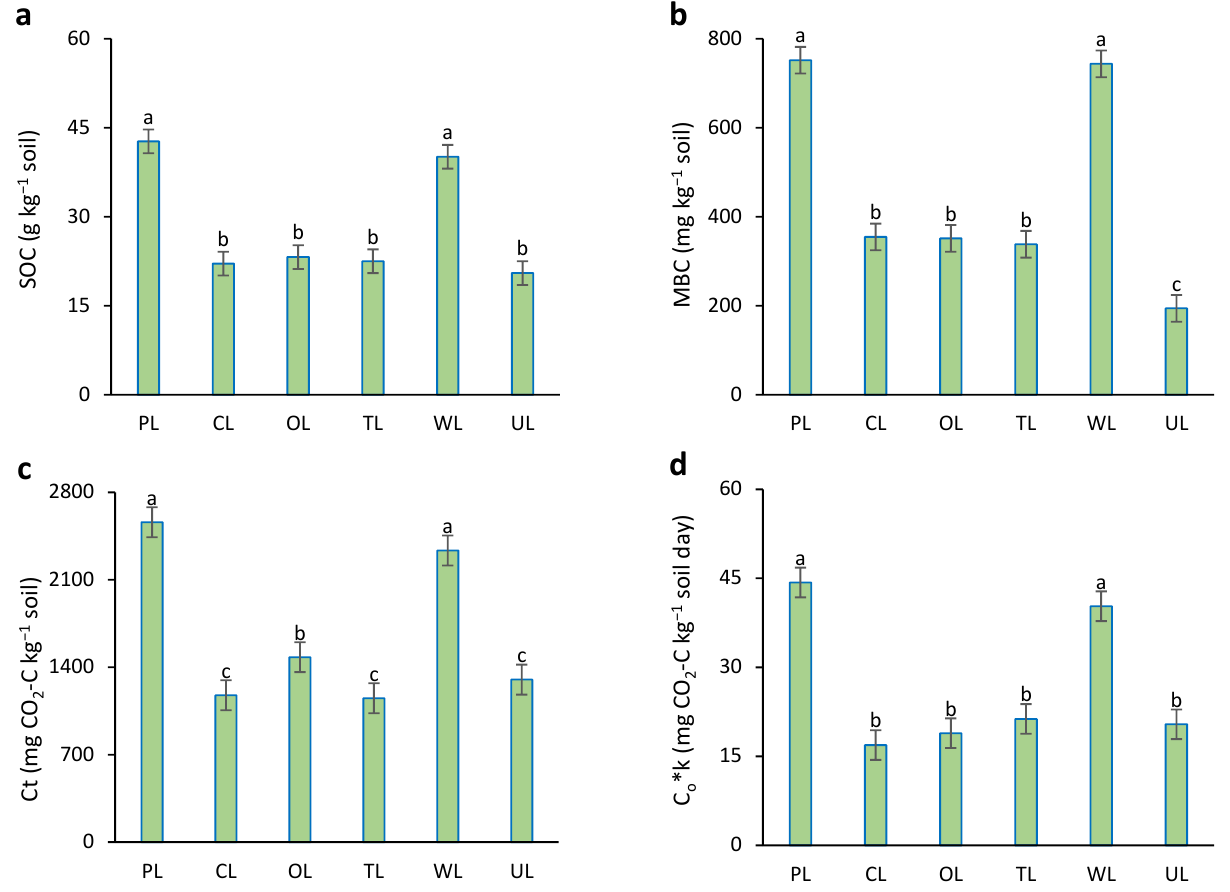
Figure 3. Soil carbon parameters influenced by different land uses. ( a ) SOC: soil organic carbon; ( b ) MBC: microbial biomass carbon; ( c ) C t : total mineralized carbon during the experiment period; ( d ) C o *k: the initial potential of carbon mineralization. PL: pastureland; CL: cropland; OL: orchard land; TL: tea land; WL: woodland; UL: uncultivated land. Similar small letters refer to no significant difference between land uses in topsoil (0–15